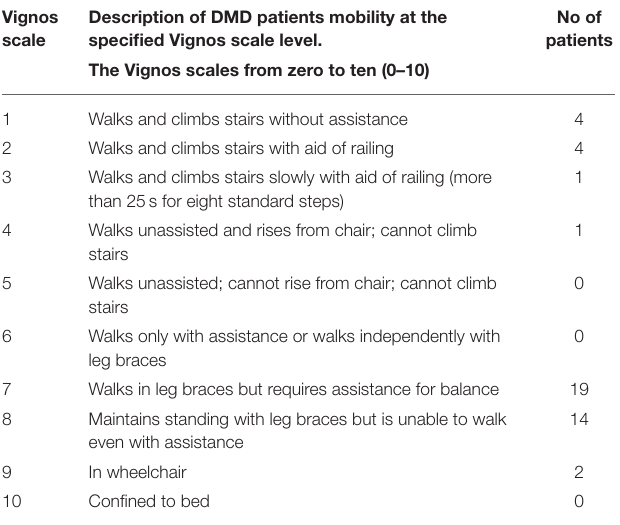
TABLE 1 | Disease status according to Vignos scale. Vignos scale